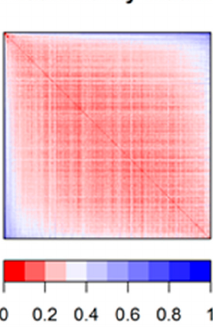
Figure 2. Dissimilarity matrix (based on Gower distance) offering a synthetic image of the chemical diversity in the dataset.